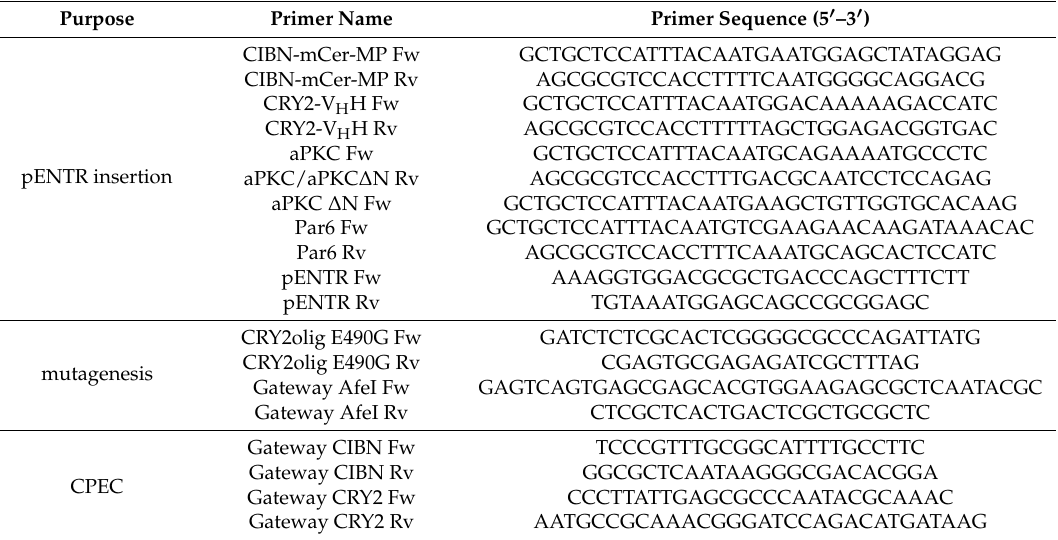
Table 1. List of primers for molecular